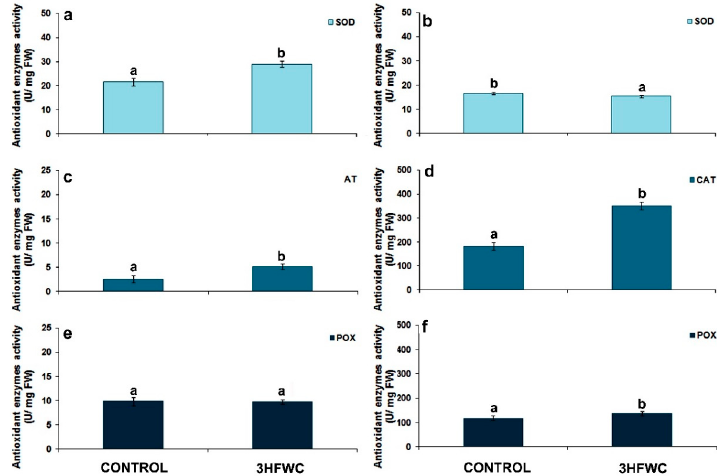
Figure 6. The effect of 3HFWC nanosubstance on superoxide dismutase (SOD), catalase (CAT) and peroxidase (POX) activity in cherry tomato leaves: ( a , b ) SOD activity in cherry tomato leaves after short- ( a ) and long-term growth( b ); ( c , d ) CAT activity in cherry tomato leaves after four ( c ) and 12 weeks ( d ) of growth; ( e , f ) POX activity in cherry tomato leaves after four ( e ) and 12 weeks ( f ) of growth. The presented data are mean value ± standard error. Different letters indicate statistically significant differences according to LSD test ( p ≤ 0.05). 2.3. Histological Analysis of Cherry Tomato Plants after Long-Term Exposure to 3HFWC Nanosubstance Detailed histological analysis revealed that 3HFWC nanosubstance deposits accumu- lated in the tomato vascular elements of the stem and leaf lamina after 12 weeks of growth (Figure 7). In the stem, discrete deposits of accumulated 3HFWC nanosubstance were ob- served as randomly spherical or conical deposits along xylem vascular elements (Figure 7a–d). Spherical deposits were observed in the leaves of plants exposed to 3HFWC nano- substance, mainly in leaf lamina (Figure 7e,h). In contrast to stem and leaves, the deposits or any visible accumulation of 3HFWC nanosubstance in cherry tomato fruits were not observed (Figure 7i,j).